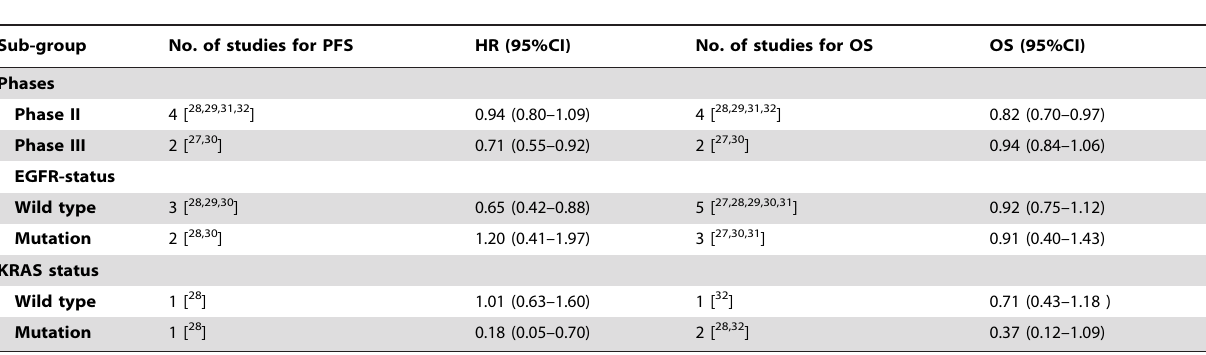
Table 3. Sub-group analysis based on study